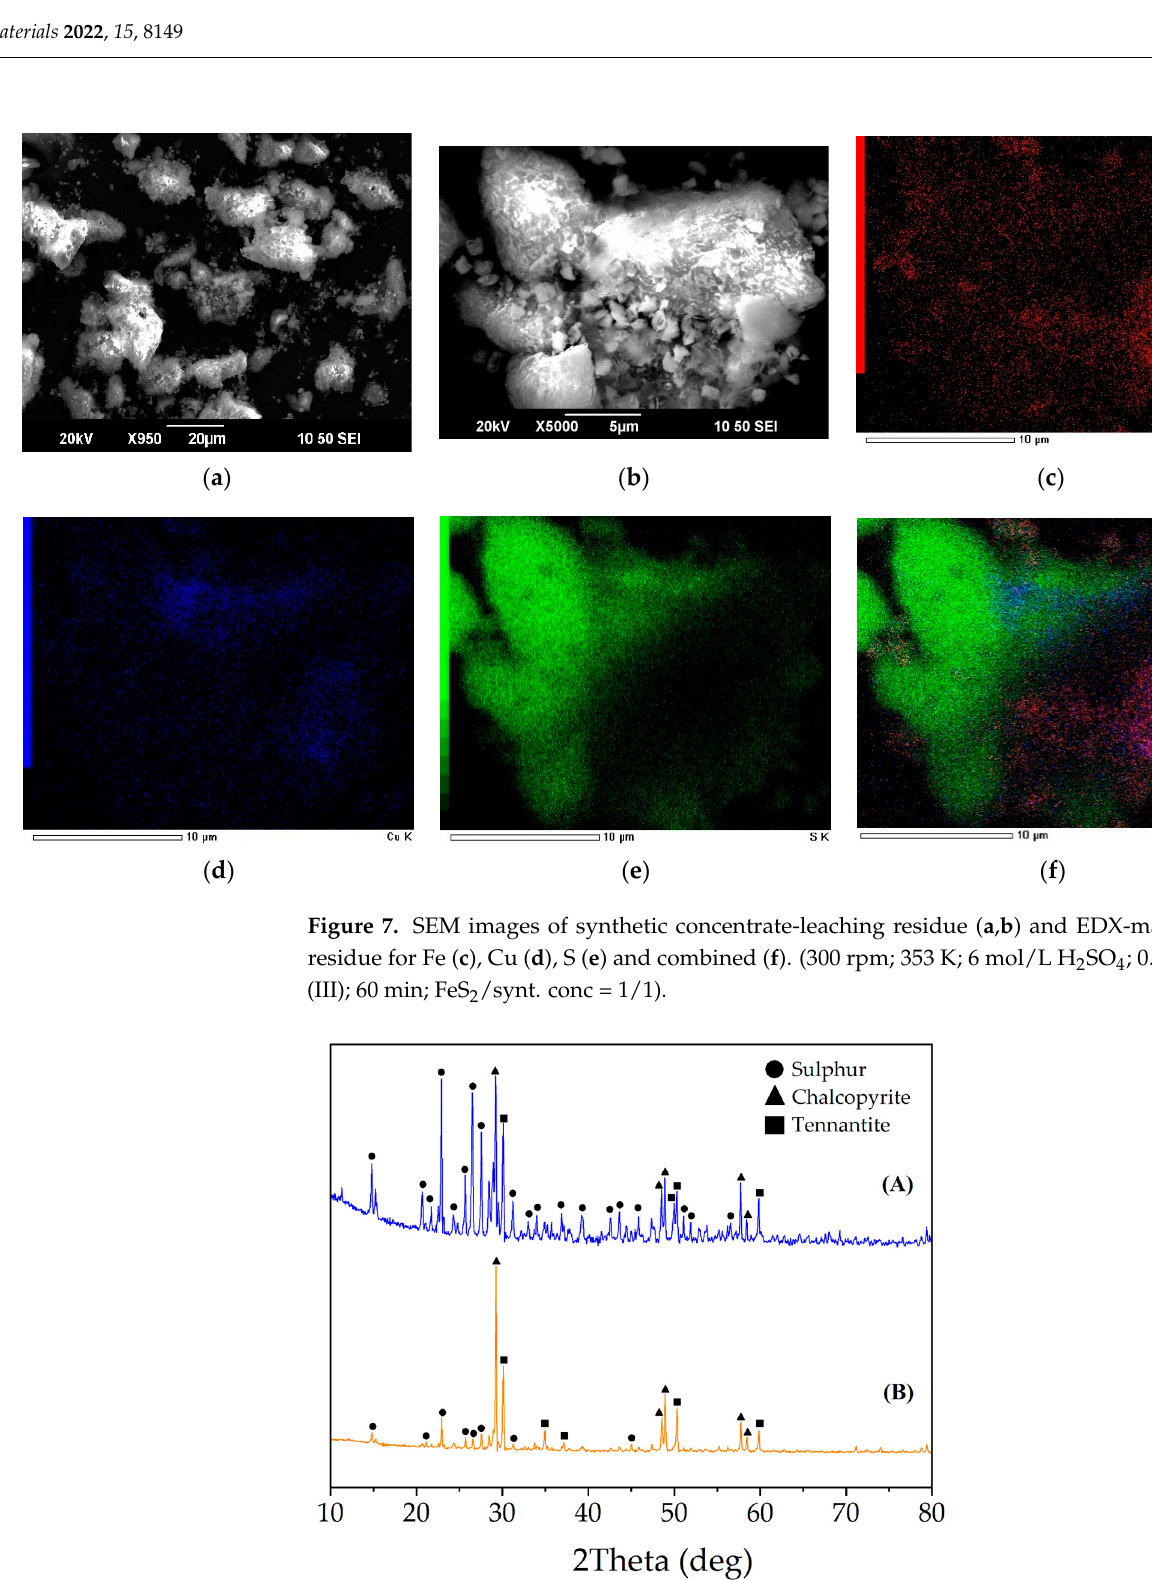
( f ) Figure 6. SEM images of synthetic concentrate-leaching residue ( a , b ) and EDX-mapping of the res- idue for Fe ( c ), Cu ( d ), S ( e ) and combined ( f ). (300 rpm; 353 K; 6 mol/L H 2 SO 4 ; 0.018 mol/L Fe (III); 60 min; no FeS 2 additive). In contrast to the experiment without the FeS 2 additive (Figure 6), the results with the additive (FeS 2 /synt. conc = 1/1) showed a lesser S° content. The Fe and Cu points indicated in one component EDX-mapping images (Figure 7c and Figure 7d, respectively) became brighter. According to Figure 7a,b, the residue has a heterogeneous surface resembling conglomerates, while the experiment without FeS 2 ad- ditive shows a more homogeneous structure due to the covering of the particles by S°. The green zones in Figure 7f correspond to the distribution of S°, while the mixture of red and